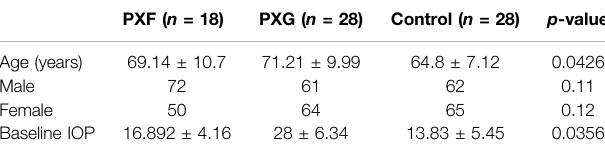
TABLE 1 | Demographic and clinical characteristics of patients included in the